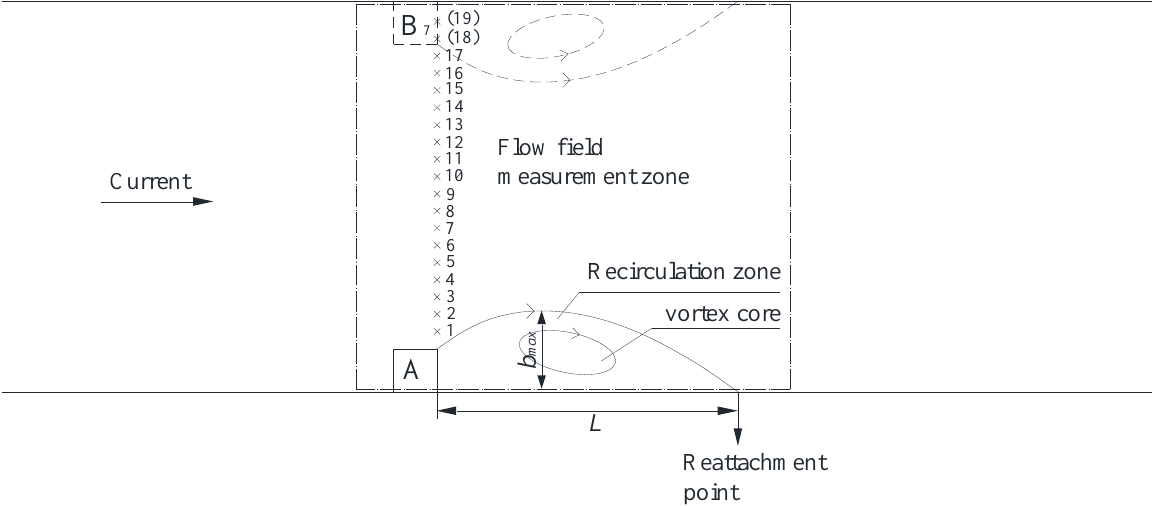
Figure 5. Schematic diagram of streamlines and observed points of velocities on the cross-section through the groin tip for the single groin (solid line) and symmetrical groins (dotted line), in which b max indicates the backflow width and L represents backflow length (top view).